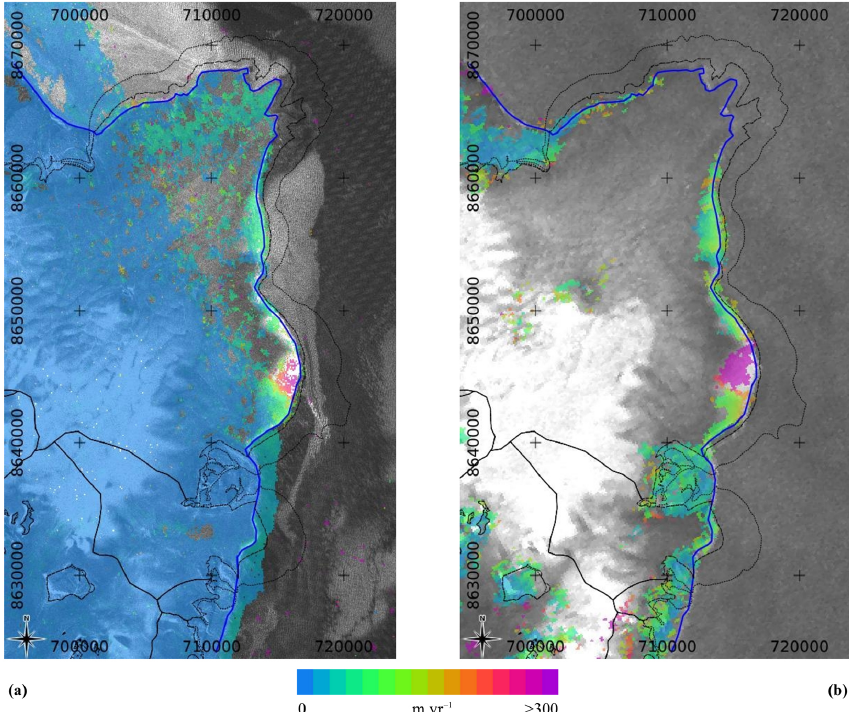
Figure 5. Ice surface velocity maps from (a) ALOS PALSAR data of the winter 2010/2011 and (b) Radarsat-2 Wide data of 21 October 2011 and 8 December 2011. Image background is a backscattering intensity image of the master scene used for offset tracking. The coastal outline in the summer of 2011 (continuous blue line) is shown along with glaciers inventories of 1971 (dotted line) and 2006–2007 (RGI 5.0, dashed